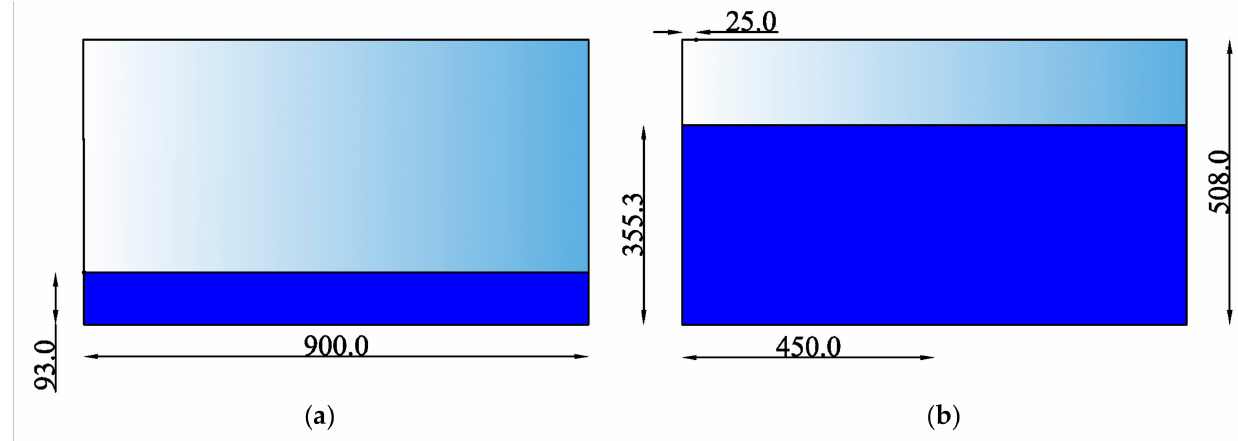
Figure 7. Schematic of the simulation tank. ( a ) Lateral sloshing. The pressure is determined at the location depicted on the left wall. ( b ) Roof sloshing. The pressure is determined at the location depicted on the top of the tank. Sloshing motion is about the axis depicted in red at the bottom of the tank in ( a ). All dimensions are given in